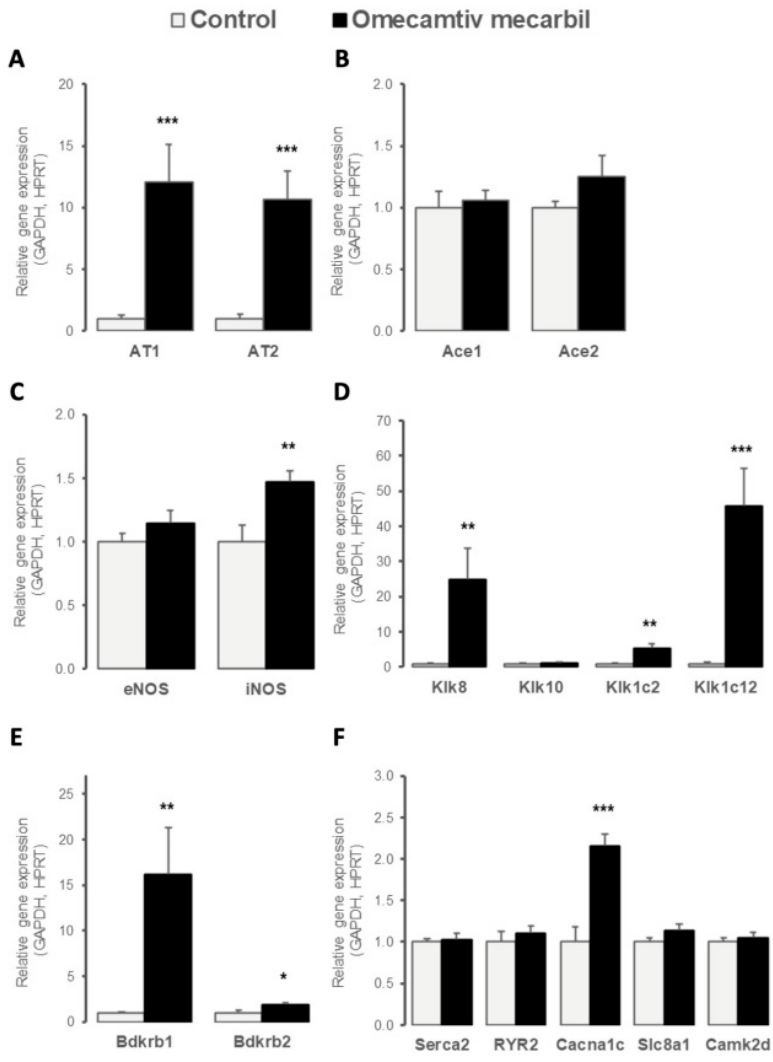
Figure 3. Myocardial left ventricular relative expression of genes controlling myocardial contractility including ( A ) AT1 and AT2 angiotensin II receptors; ( B ) ACE1 and ACE2 angiotensin-converting enzymes; ( C ) endothelial ( eNos or Nos3) and inducible ( iNos or Nos2) nitric oxide synthases; ( D ) major cardiac actors of kallikrein ( Klk 8, Klk 10, Klk 1c2, and Klk 1c12)-( E ) bradykinin ( Bdkrb 1and Bdkrb 2) system and of ( F ) Ca 2+ -dependent excitation–contraction Atp2a , Ryr2 , Cacna1c , Slc 8a1, and Camk2d seven days after omecamtiv mecarbil (OM; n = 6; black bars) versus placebo (n =